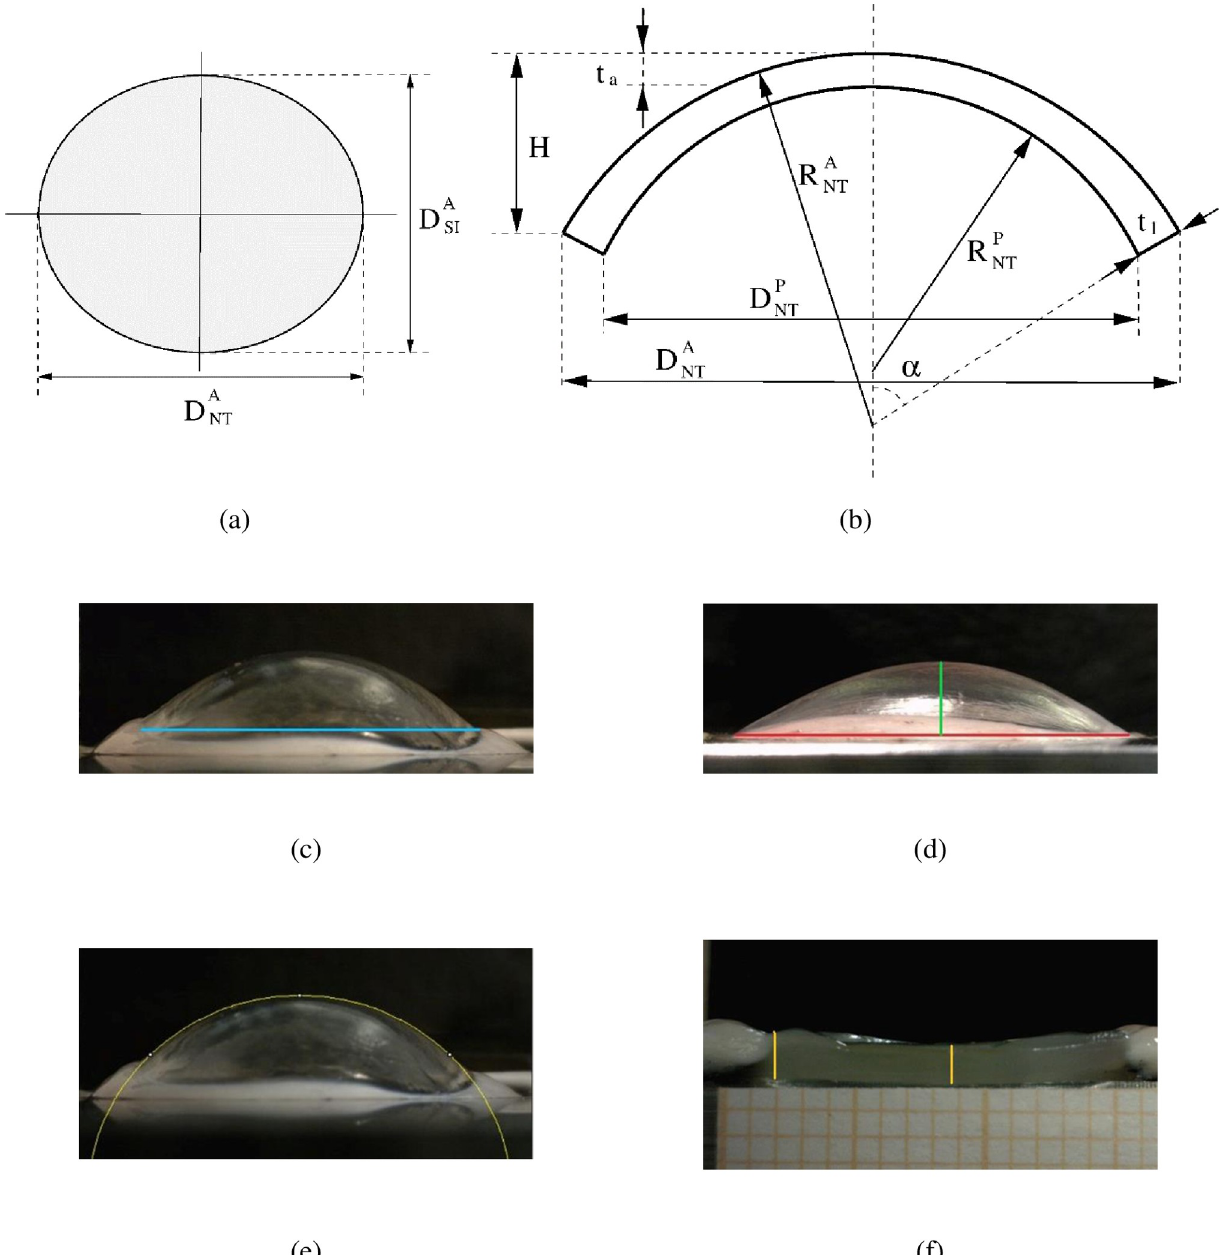
Fig 3. (a) In-plane view of the elliptical shape of the pig cornea. (b) NT corneal section: geometrical meaning of the parameters acquired through the imaging software: in-plane anterior diameter D A ; in-plane posterior diameter D P ; anterior curvature R ; posterior curvature R P NT NT limbus thickness, t ; apex thickness t . (c-f) Acquisition of the main geometrical parameters of the cornea through imaging software. (c) SI in-plane l a anterior diameter D A (blue line). (d) NT in-plane anterior diameter D A (red line) and apex elevation H (green line). (e) Anterior curvature R A SI NT Limbus thickness, t , (yellow line on the left) and apex thickness t (yellow line at the center). l a